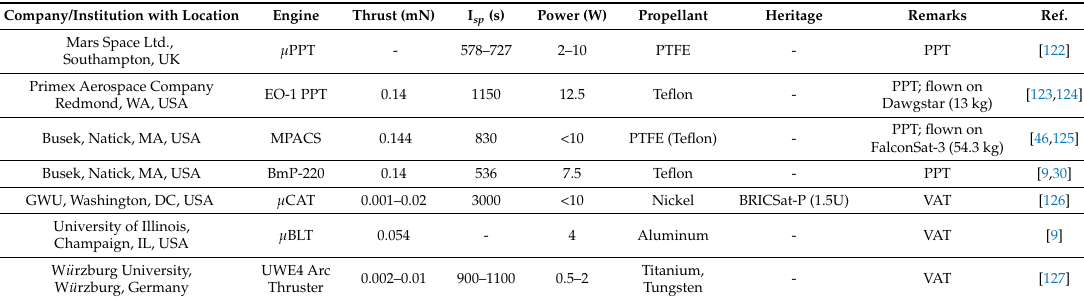
Table 8. Summary of Pulsed Plasma and Vacuum Arc